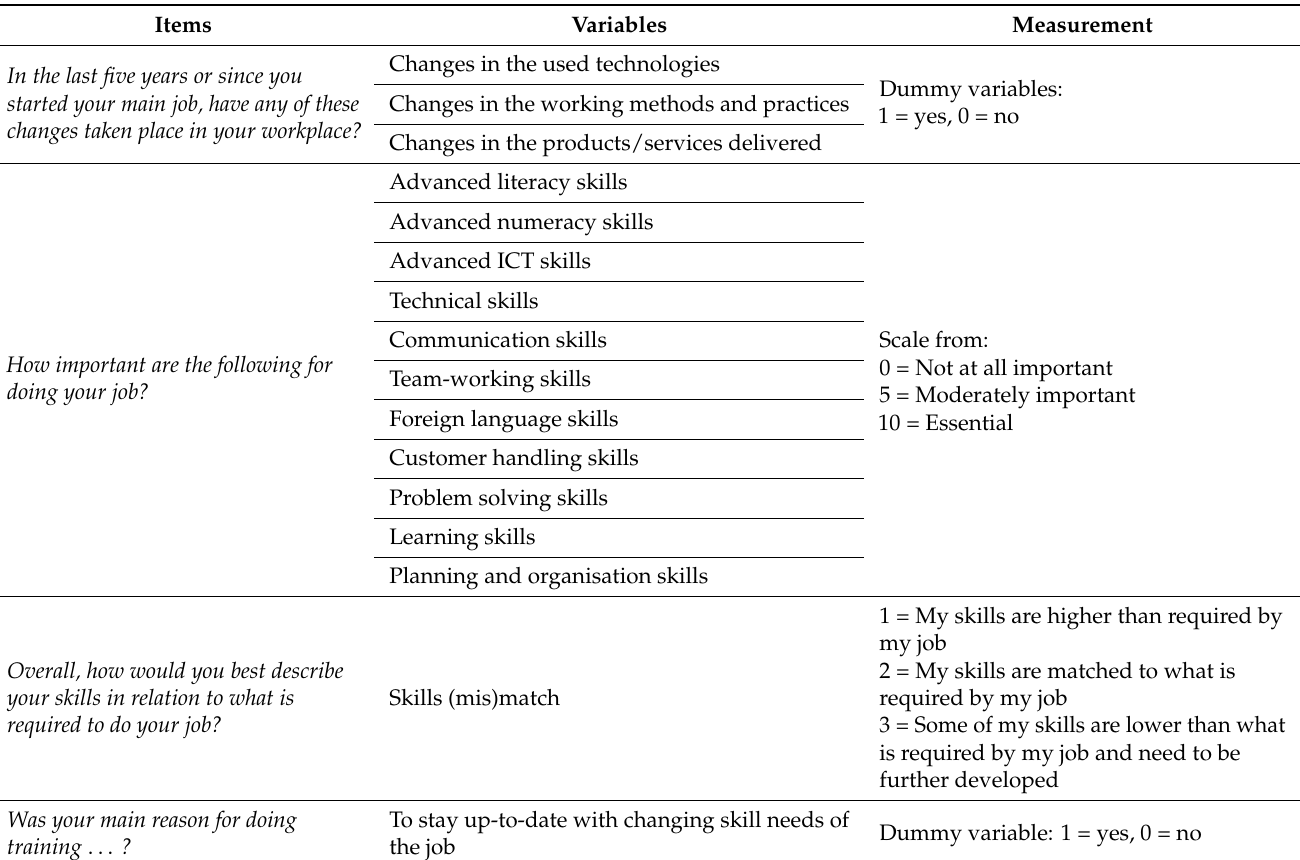
Table 1. Independent variables included in the logistic